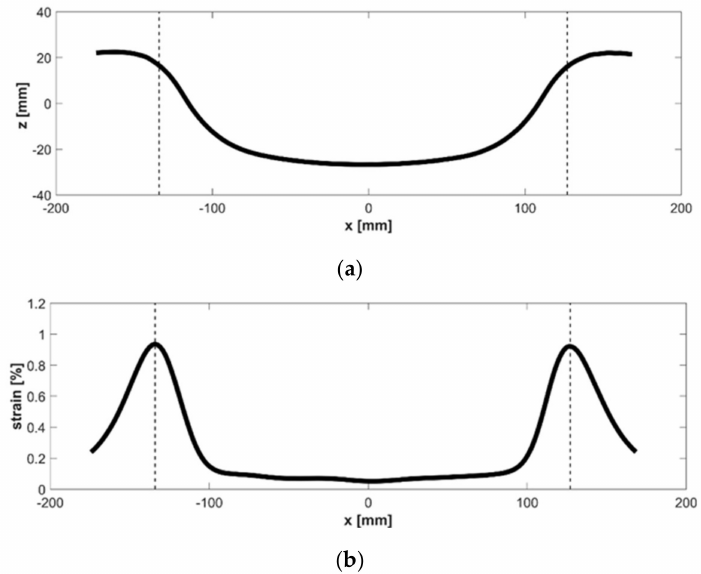
Figure 11. Specimen #29 data obtained from DIC analysis after the first pressure cycle: ( a ) shape of the dent; ( b ) strain distribution along a longitudinal line.